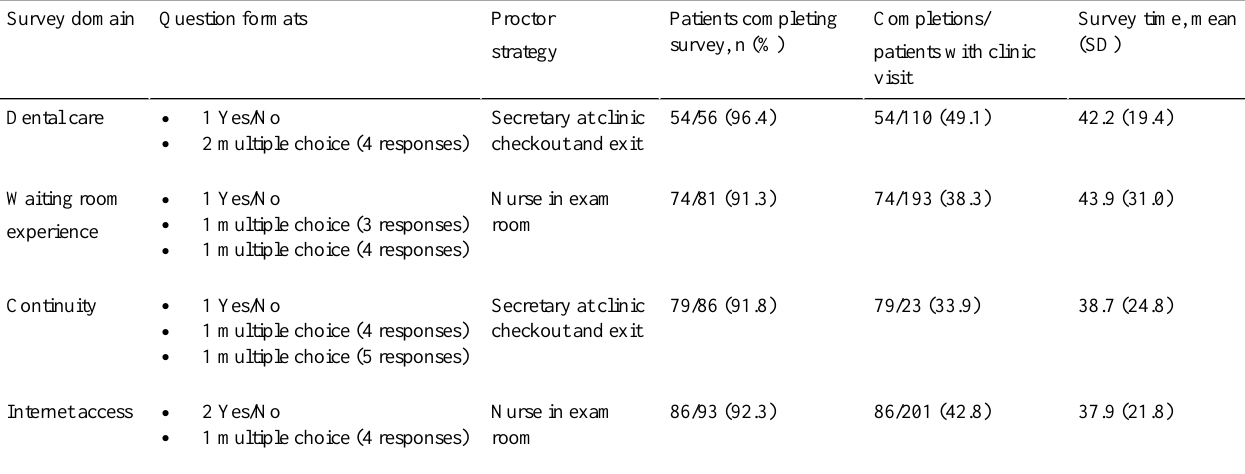
Table 1. Summary of the four patient surveys.